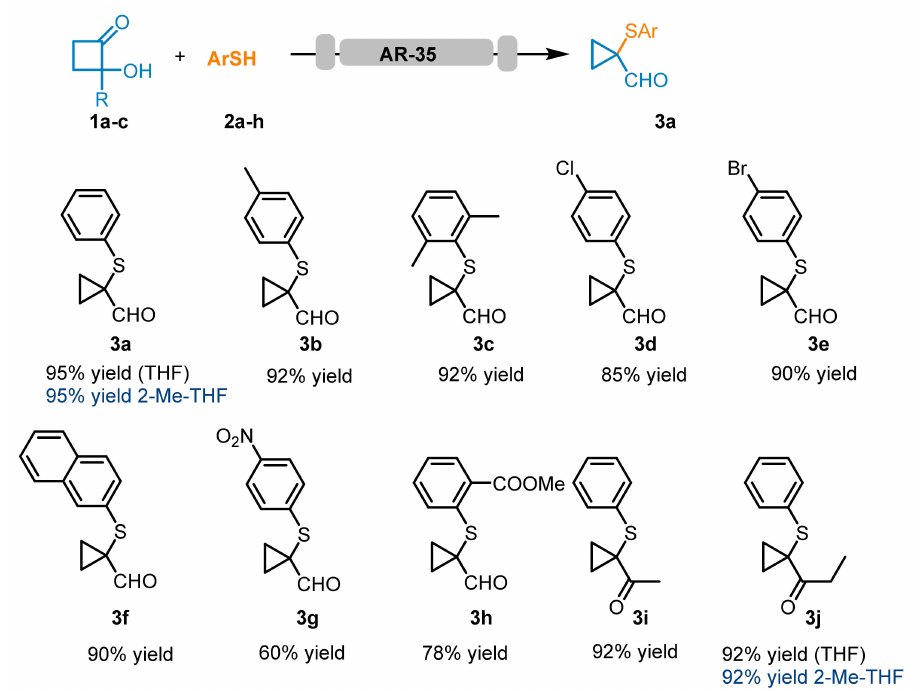
Figure 3. ( a ) Representative diagram of the continuous-flow system used for the synthesis of cyclo- propyl carbaldehydes starting from 1a and benzene thiol 2a ; ( b ) 5 cm stainless steel column packed with AR-35; ( c ) 2, 10 and 15 cm AR-35 packed columns; ( d ) column components.